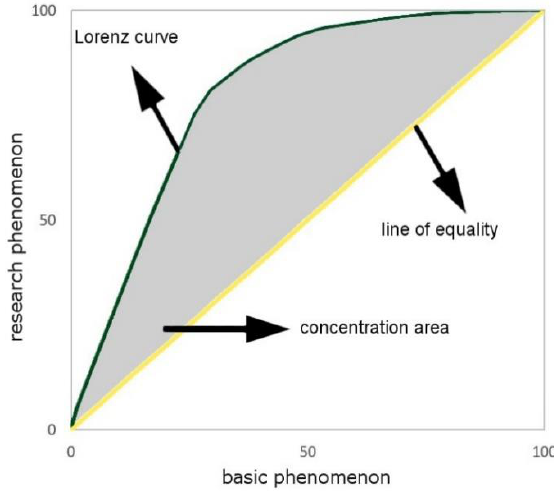
Figure 2. Lorenz curve. Source: own elaboration.